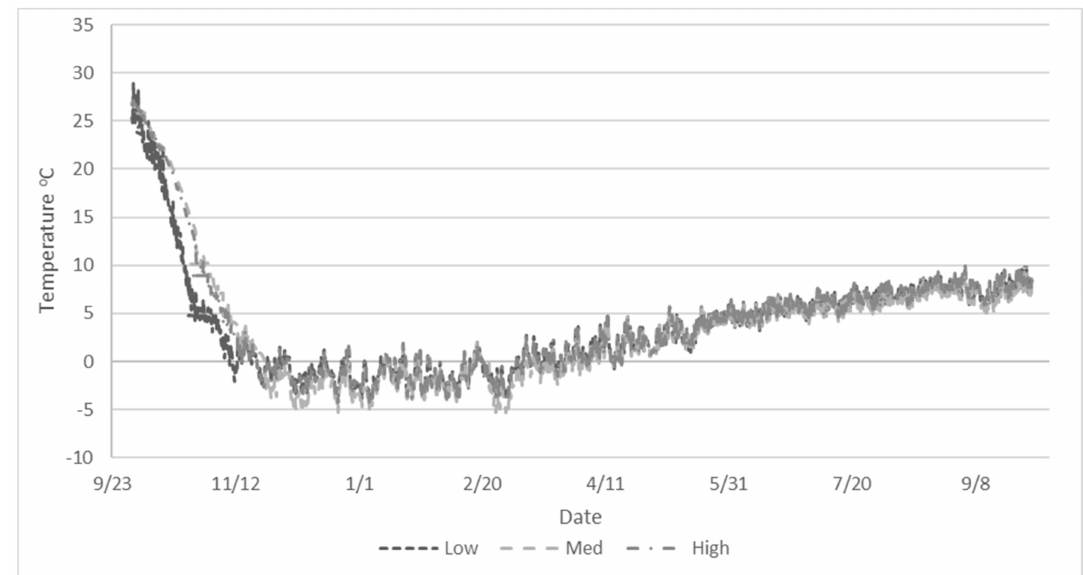
Figure 5. The average values of the temperature sensors for each of the three cable configurations defined in Figure 2. as low, medium, and high, for a one-year controlled aeration simulation of 1346 MT of maize beginning 1 October, 2014. The fan was turned on whenever ambient air was cooler than the average of the sensors and the average was above 0 ◦ C.